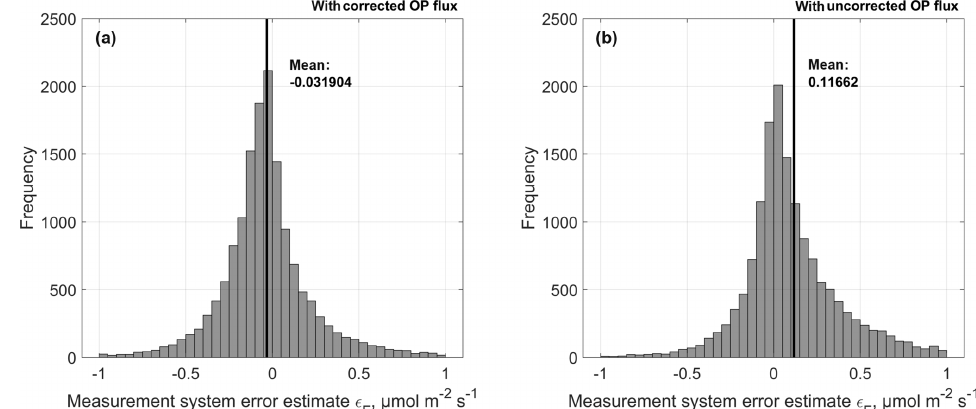
Figure 6. Distributions of the measurement system errors (cid:15) estimated using the paired-observations approach for differences between closed path and corrected (a) as well as uncorrected (b) open-path (OP)